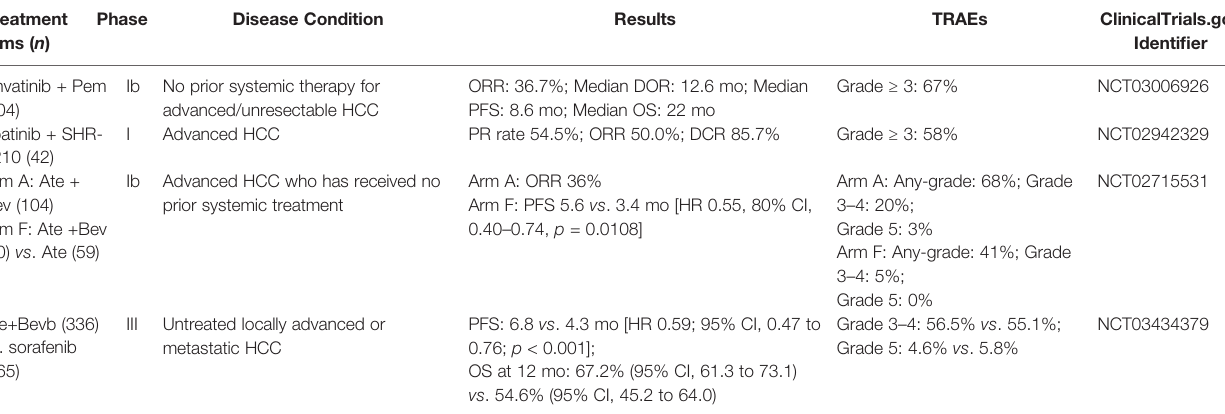
TABLE 2 | Completed clinical trials of combining immune checkpoint inhibitors with antiangiogenic drugs in HCC. Treatment arms ( n )